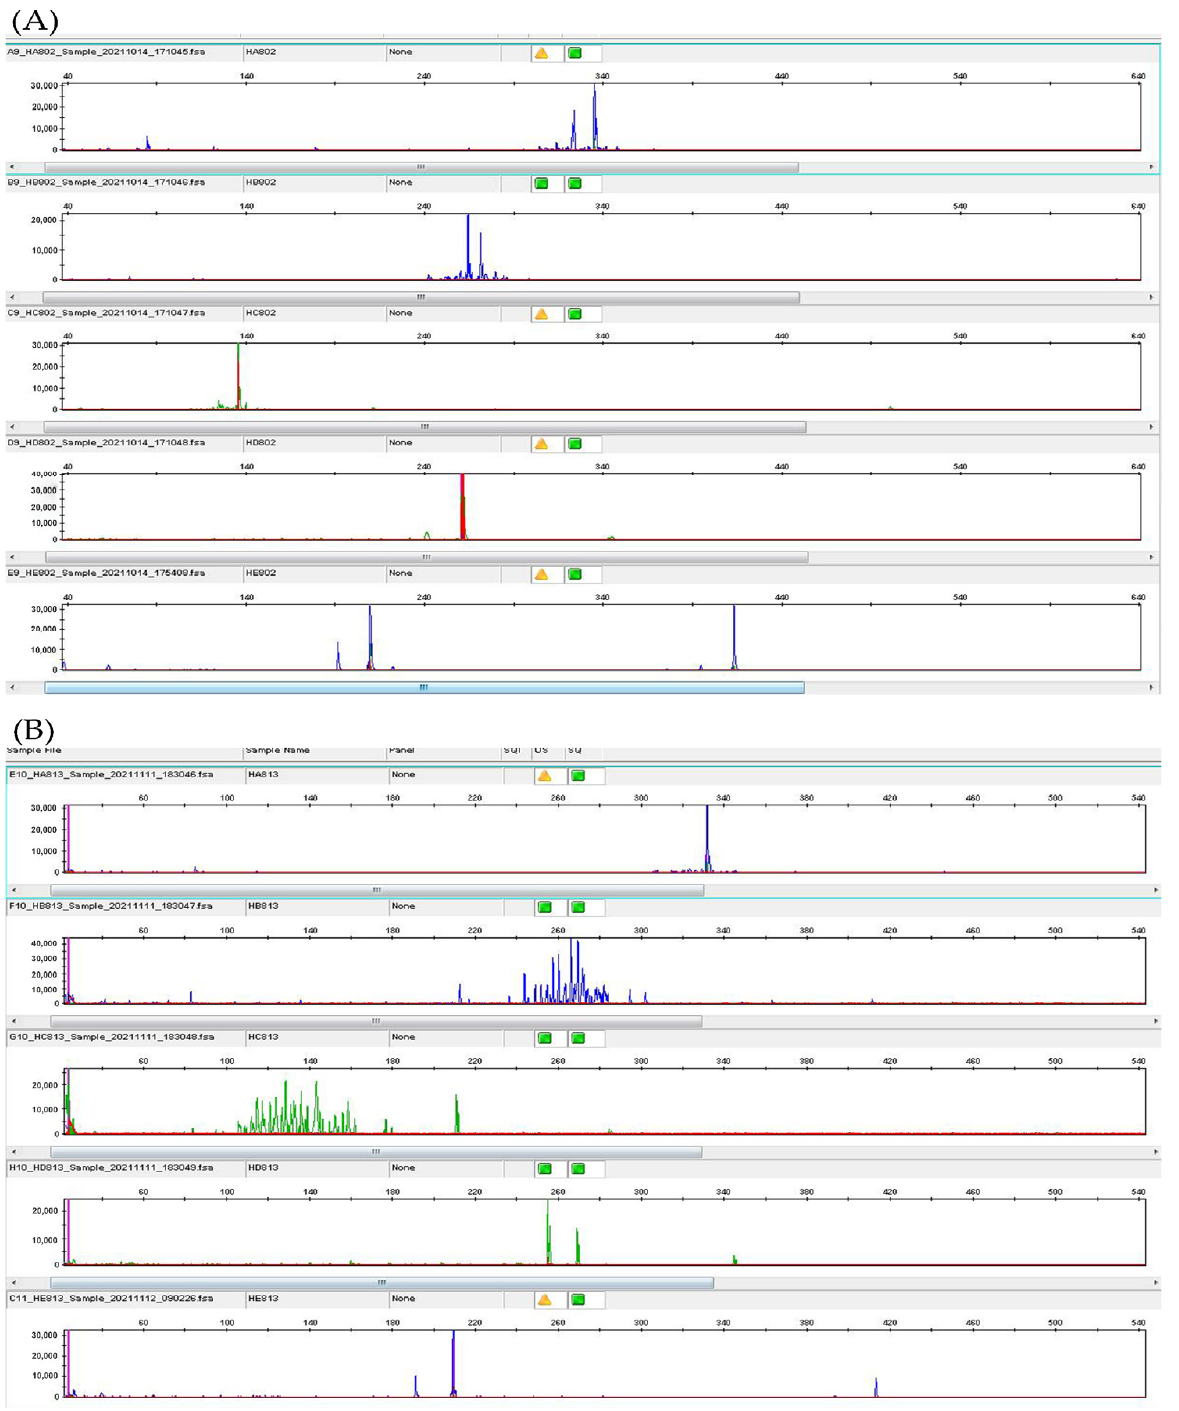
Figure 3. From top to bottom. ( A ) IgH rearrangement of esophagus biopsy: target segments FR1-JH, FR2-JH, FR3-JH, DH-JH display monoclonal. ( B ) IgH rearrangement of parotid biopsy: target segments FR1-JH, and DH-JH display monoclonal.